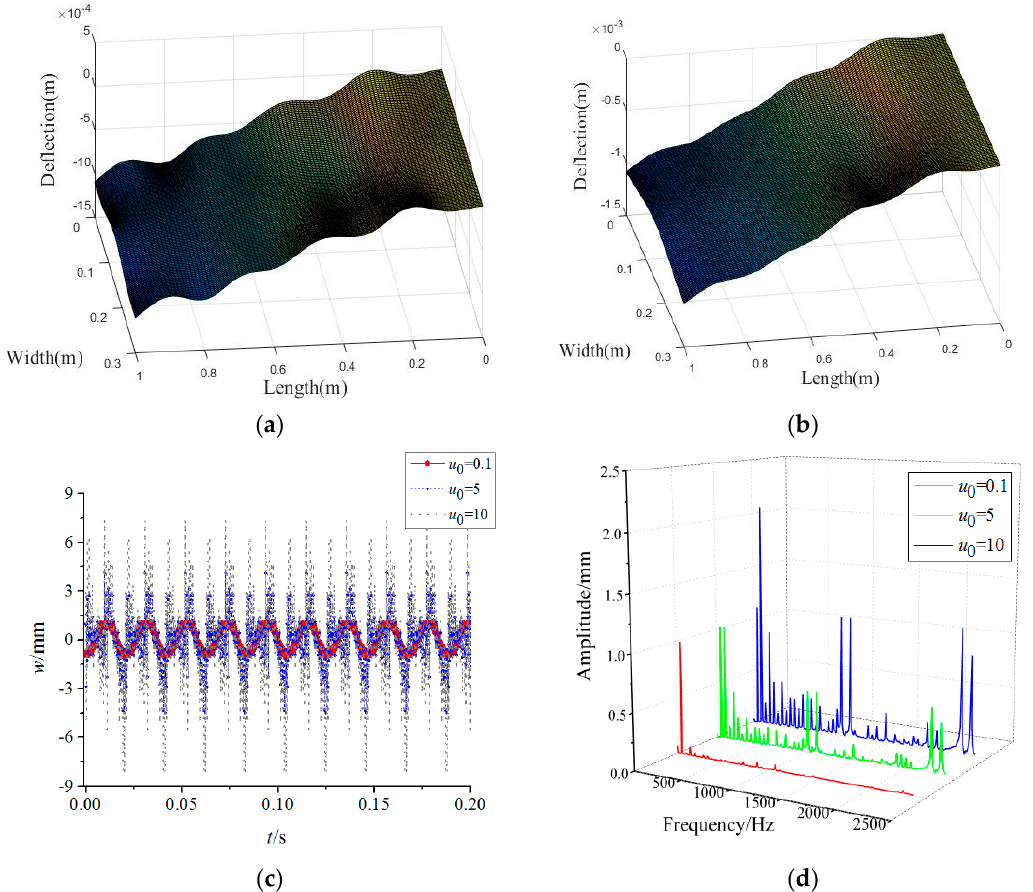
Figure 5. Effects of base excitation on forced vibration responses of the rotating FGM plate ( a ) u 0 = 5, ( b ) u 0 = 10, ( c ) time-domain response, ( d ) frequency-domain response.